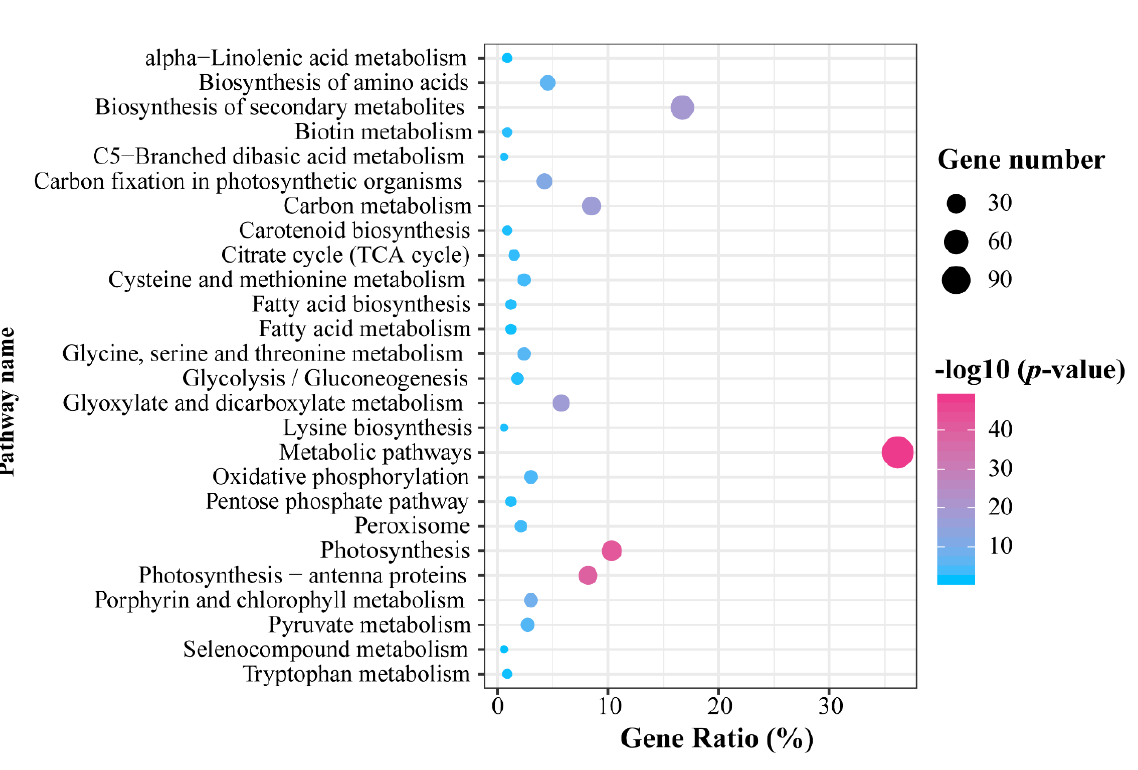
Figure 2. KEGG pathway enrichment analysis of total differentially expressed proteins.